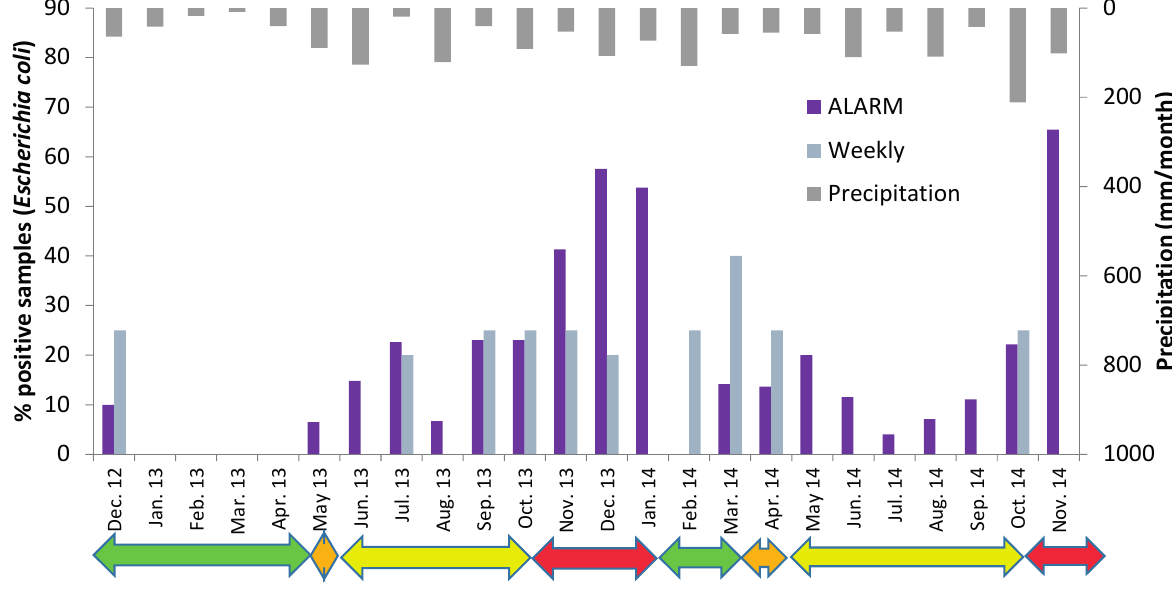
Figure 5. Detection of Escherichia coli in the raw water at Oset water treatment plant by the fully automated Colifast ALARM (daily samples) and the weekly routine samples in the period December 2012 to November 2014. Green arrows indicate periods with ice cover, orange arrows: Spring turnover, yellow arrows: summer stagnation and red arrows: autumn turnover. Monthly precipitation is also